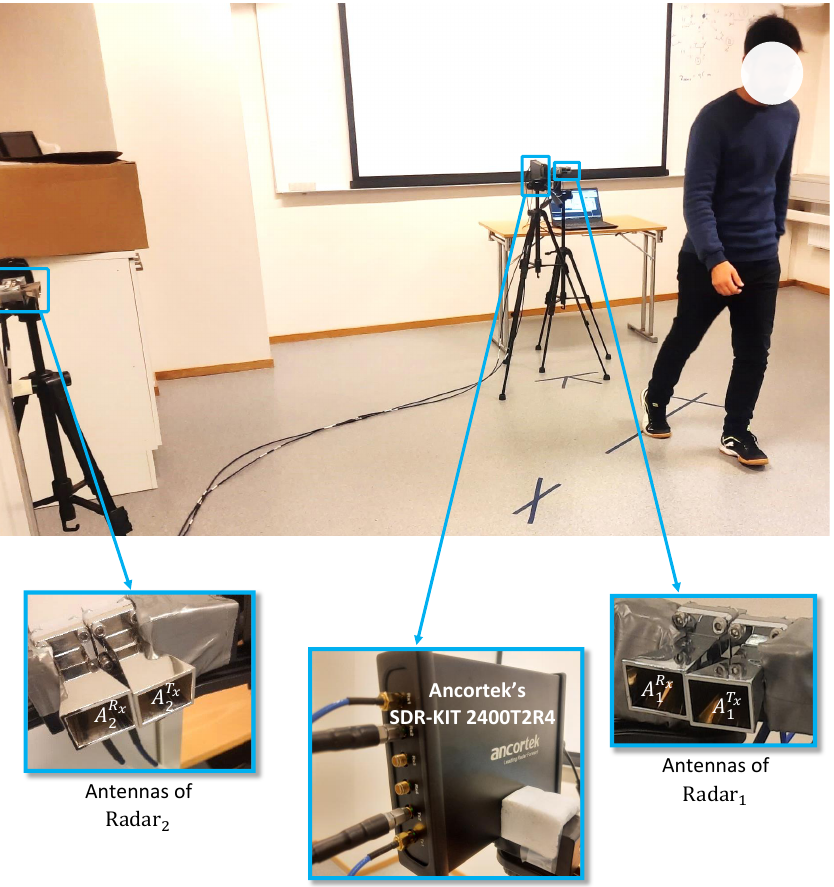
Figure 6. The distributed 2 × 2 MIMO radar setup in the presence of a moving person walking in an indoor